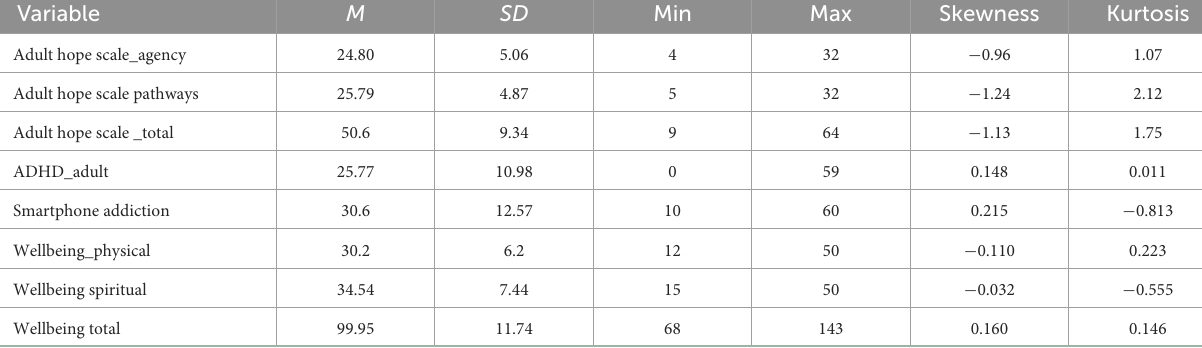
TABLE 1 Descriptive statistics.